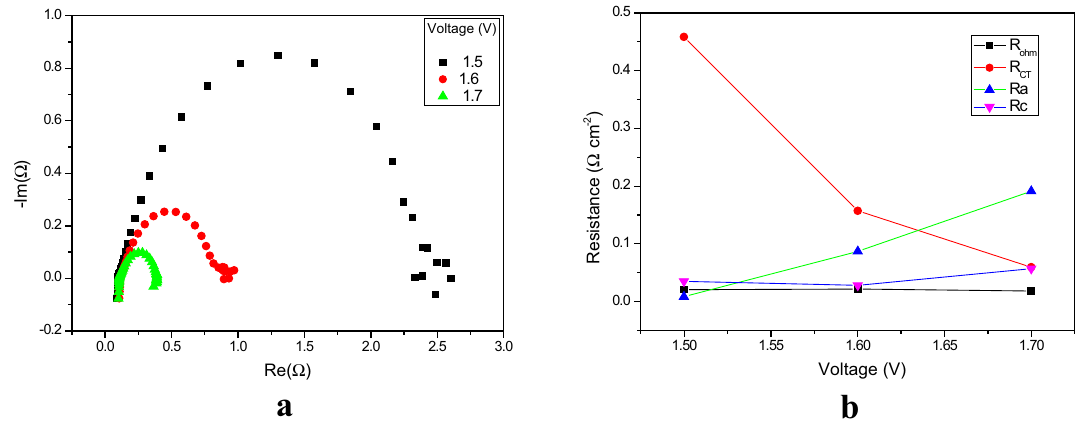
Figure 3. (a) Nyquist plots of the EIS measurements (from 100 kHz to 1 MHz), at amplitude 50 mA, at lower voltages. ( b) Variation in the electrochemical resistances as a function of lower